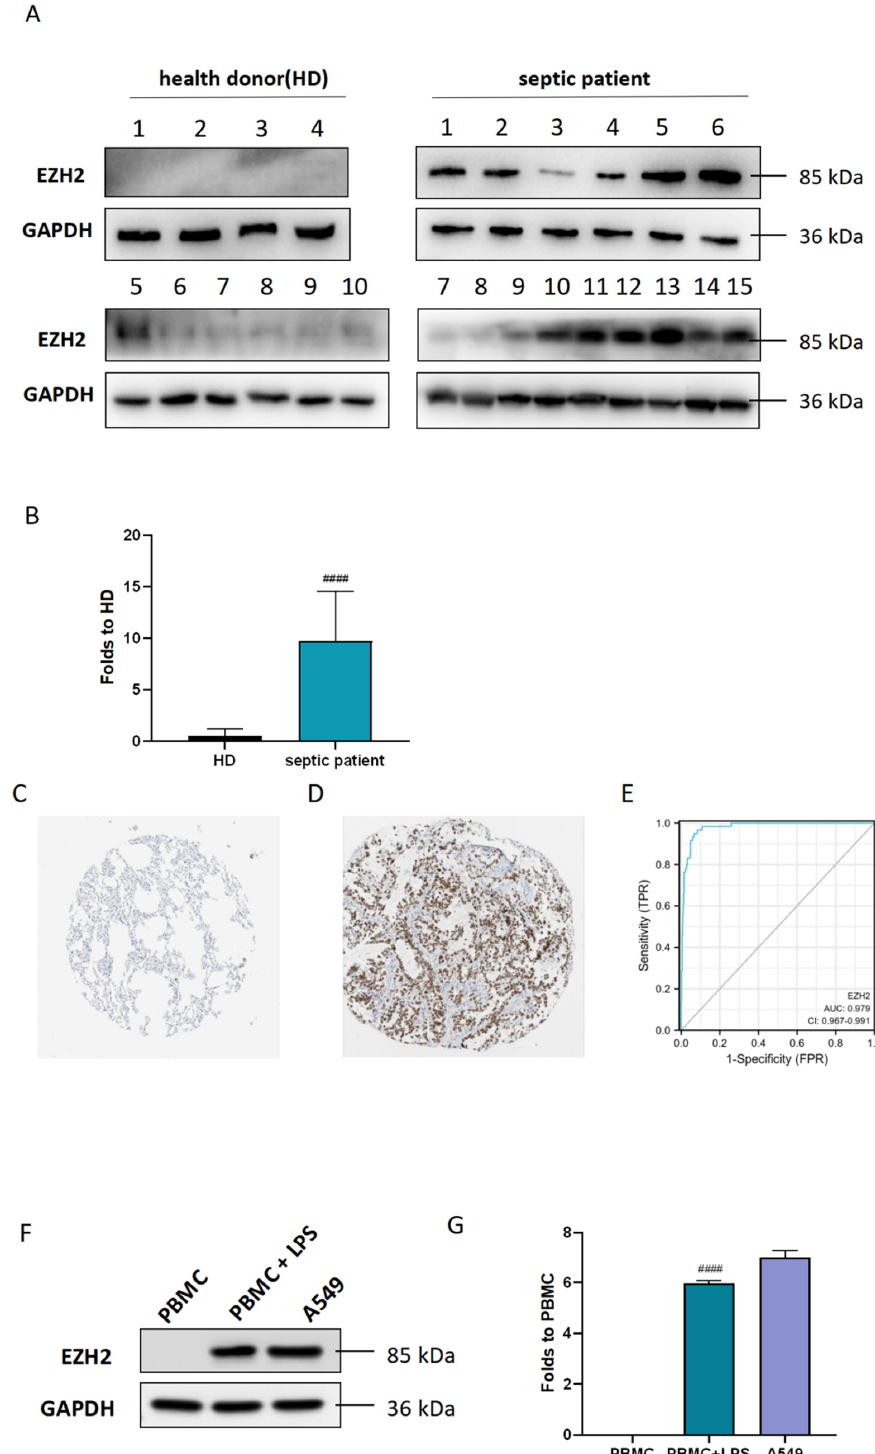
Figure 2. EZH2 could be a potential biomarker for SALI and NSCLC. ( A , B ) Western blot assay was performed to assess the EZH2 expression level in healthy donors (HDs) and septic patients. The fold expression was measured by densitometric analysis. ( C , D ) Representative IHC staining of EZH2 in normal and NSCLC tissues from the HPA database. ( E ) ROC curve of EZH2 in NSCLC patients from the TCGA database. ( F , G ) Western blot assay was performed to assess the EZH2 expression level in LPS-induced PBMCs and A549. The fold expression was measured by densitometric analysis. Values are expressed as mean ± SD. #### p < 0.001, relative to the control group, n = 3.